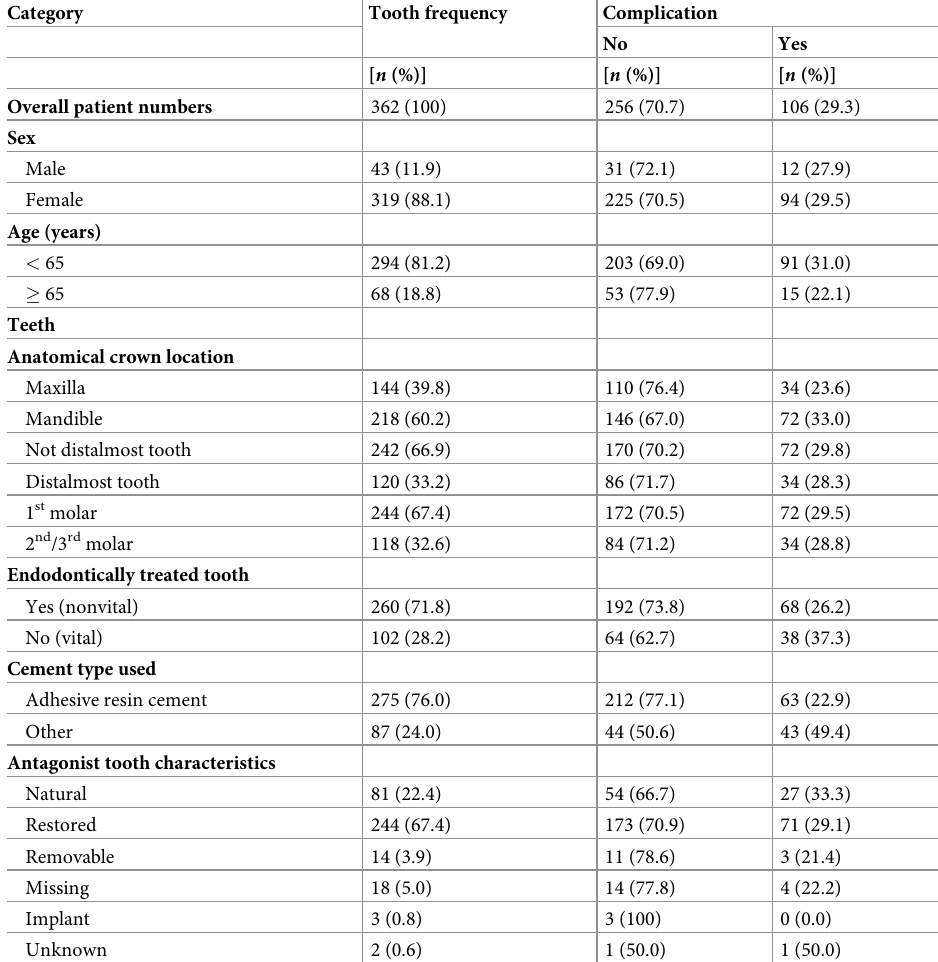
Table 1. Baseline characteristics of study subjects with